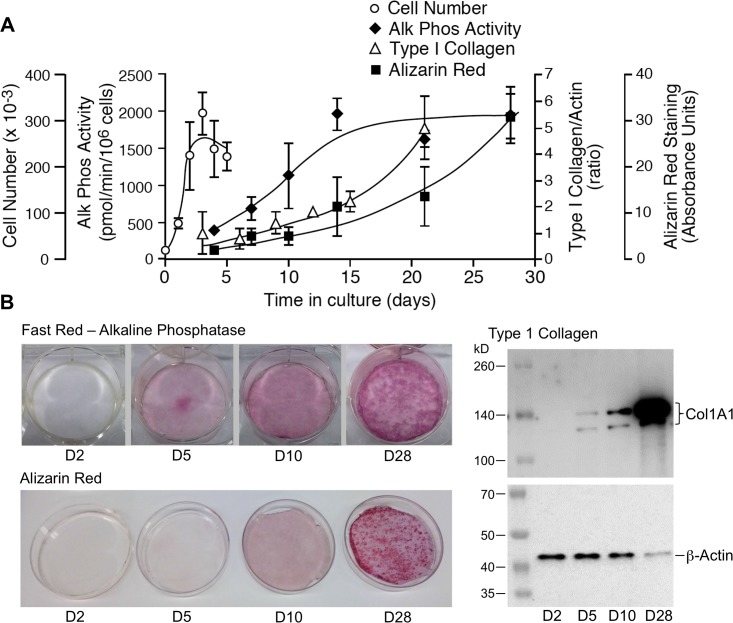
MC3T3-E1 osteoblast maturation in vitro.MC3T3-E1 cells were seeded in 6-well tissue culture plates at an initial density of 20,000 cells/well and maintained in culture for up to 28 days. A. Graph depicting change in cell number (days 1–5), secreted alkaline phosphatase activity (days 4–28), type 1 collagen synthesis (days 3–21), and matrix mineralization (days 4–28) associated with MC3T3-E1 differentiation. Data shown are the Mean ± SE of three biological replicates at each time point. These data were used to select time points representing proliferating preosteoblasts (day 2), early and late differentiating osteoblasts (days 5 and 10), and active osteoblasts (day 28), for subsequent mRNA isolation. B. Representative Fast Red staining for alkaline phosphatase (top left), type 1 collagen:β-actin western blotting (right), and Alizarin Red staining for matrix mineralization (bottom left) performed at days 2, 5, 10 and 28 to illustrate the differentiation state of cells at the time points used for RNA isolation. Note that as MC3T3-E1 osteoblasts mature, extracellular matrix, e.g. type 1 collagen, becomes an increasingly large fraction of the total protein in the sample.